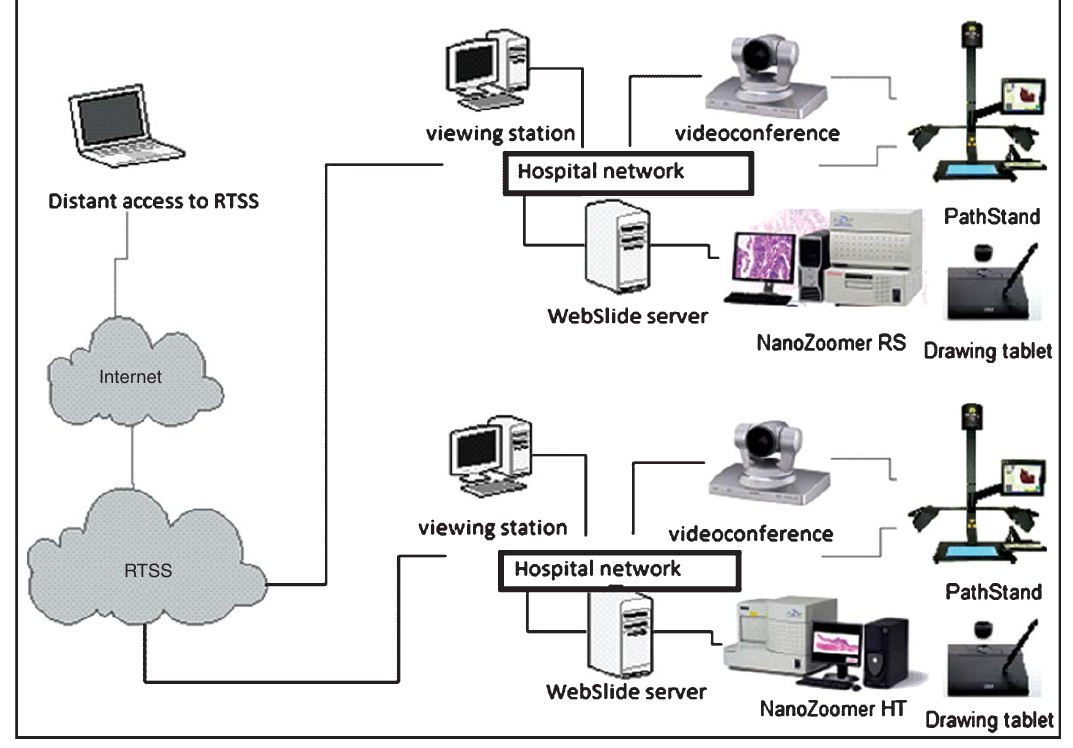
Fig. 2. Equipment provided to the 21 hospitals participating in the Eastern Qu´ebec telepathology project (RTSS: R´eseau de t´el´ecommunications